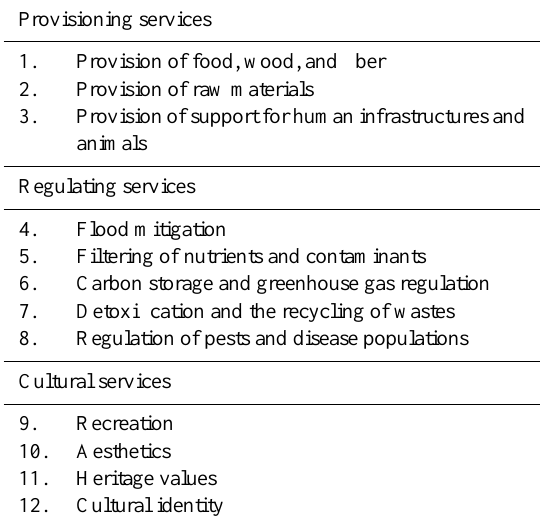
Table 1. The 17 UN Sustainable Development Goals (http:// sustainabledevelopment.un.org/focussdgs.html).